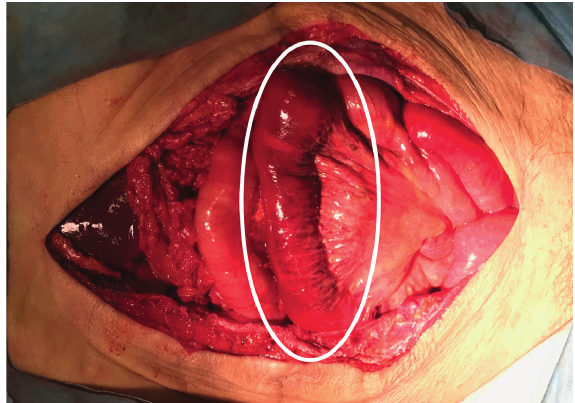
Figure 4: Operative findings on second-look surgery, with a pale small intestine, indicating that it might become ischemic